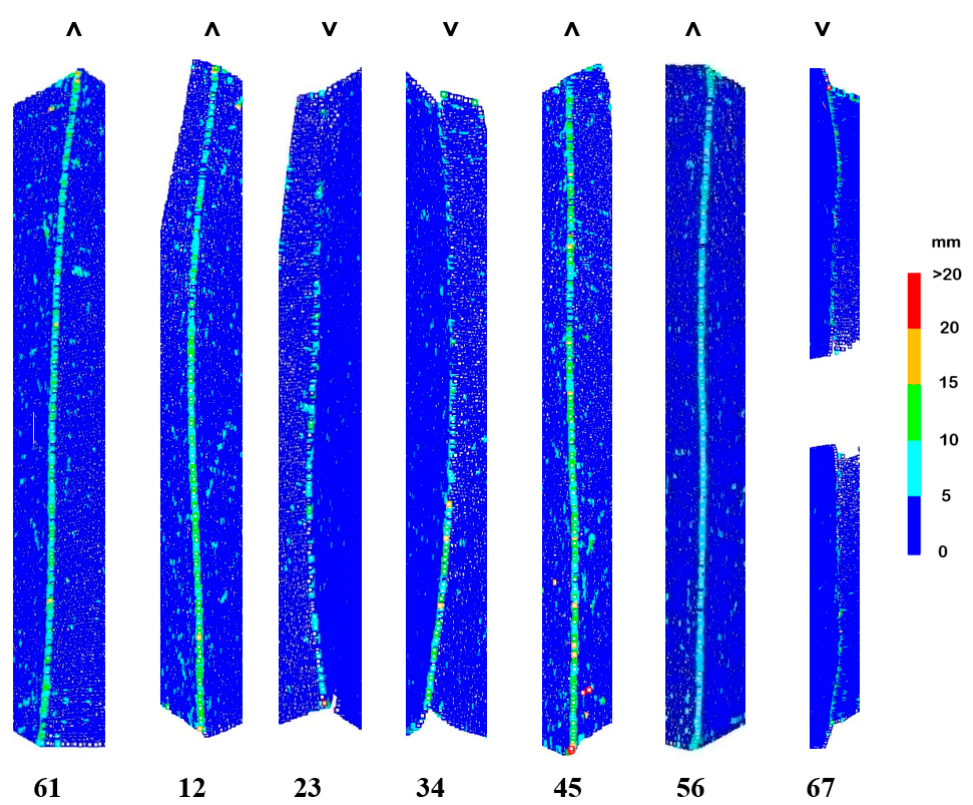
Figure 9. Point cloud deviations from the surface along single edges separating main patches of the structure. The symbols ˅ and ˄ denote concave and convex edges.